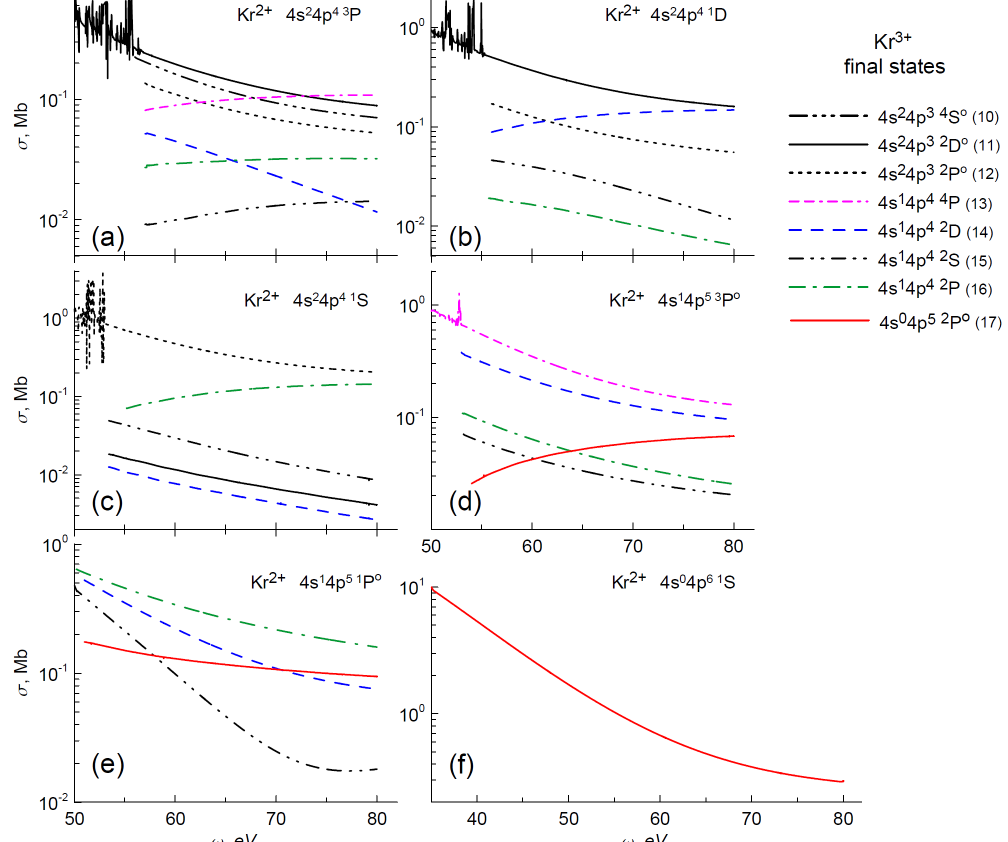
Figure 8. Photoionization cross-sections from different multiplet states of Kr 2 + . indicated in the panels. Legends for the curves with the corresponding final Kr 3 + states and their numbers (in parenthesis) according to Table 1 are presented at the right. (See